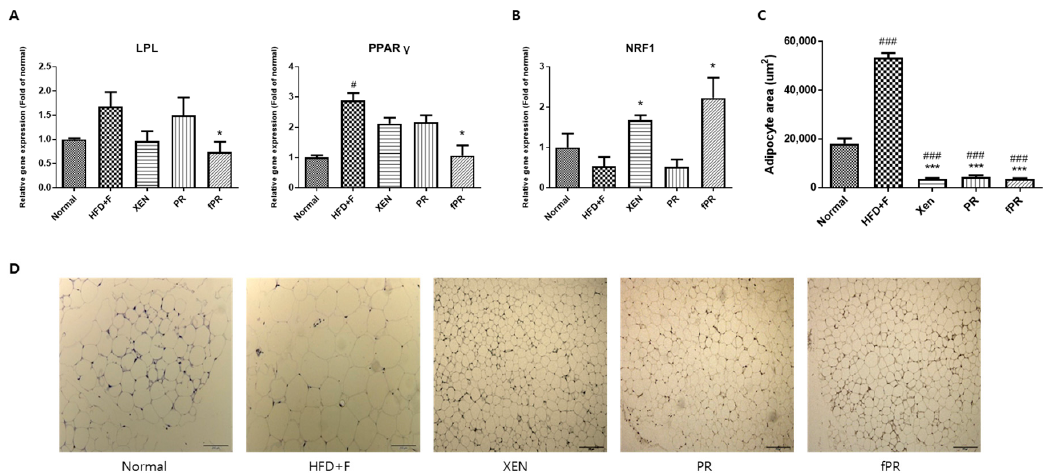
Figure 5. E ff ects of the herbal treatments on adipogenesis and gene expressions of key lipogenic factors and regulators in hepatic and intestinal fat tissues. ( A ) Expression of the LPL gene in liver tissue. ( B ) Expressions of the PPAR γ and NRF1 genes in the intestinal fat tissue. ( C , D ) Intestinal fat tissue stained with hematoxylin and eosin; the sizes of the adipocytes are presented. Data are expressed as means ± SD and were evaluated using one-way ANOVA. # p < 0.05, ### p < 0.001 compared to the normal group; * p < 0.05, *** p < 0.001 compared to the HFD + F-fed group.